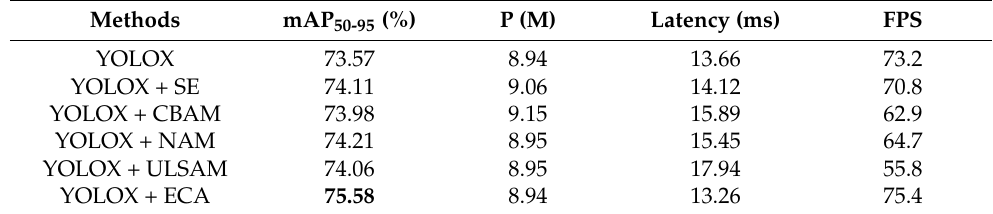
Table 1. Test results of attention mechanism blocks on DOTA.